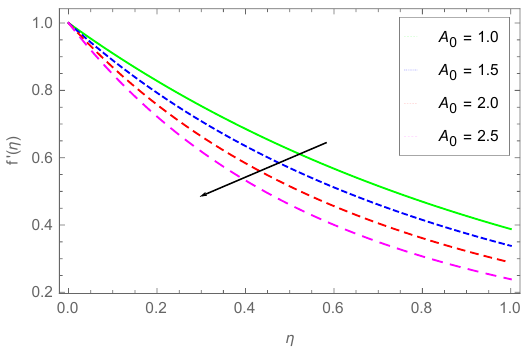
Figure 2. f (cid:48) ( η ) dependence on A 0 .